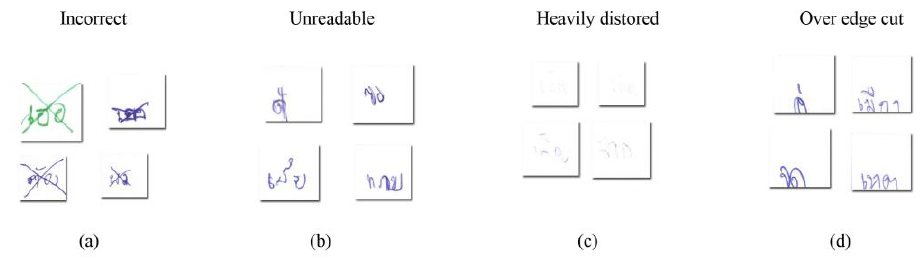
Figure 6. Example of eliminated images: ( a ) depicts incorrect writing, ( b ) depicts unreadable images, ( c ) shows examples of heavily distorted images, and ( d ) shows over edge cuts.